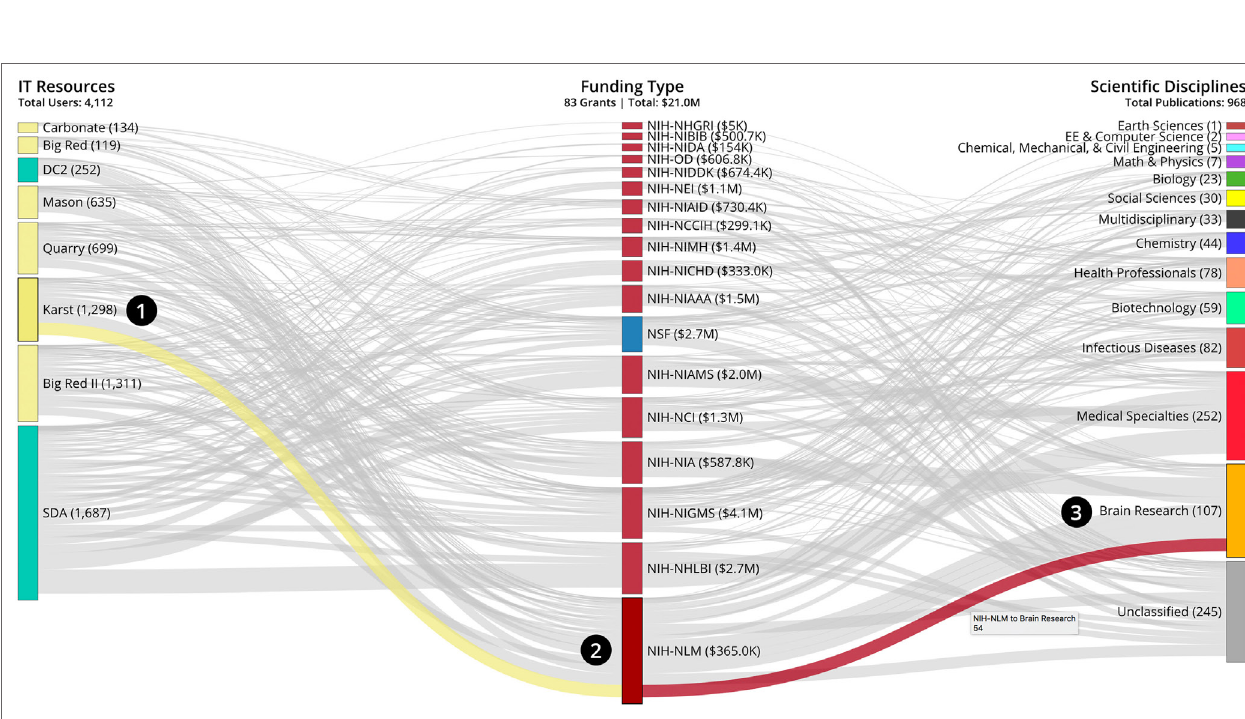
FigUre 6 | XD metrics on demand value analytics Funding and Publication Impact Visualization , see interactive version at http://demo.cns.iu.edu/xdmod-p/ impact.html.